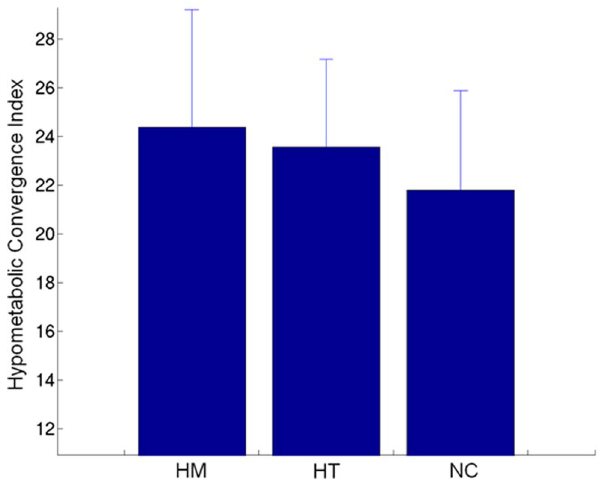
Figure 1. Mean Hypometabolic Convergence Index (HCI) for APOE e 4 homozygotes (HM), heterozygotes (HT) and non- carriers (NC) showed a positive association between the HCI and the APOE e 4 gene dose.